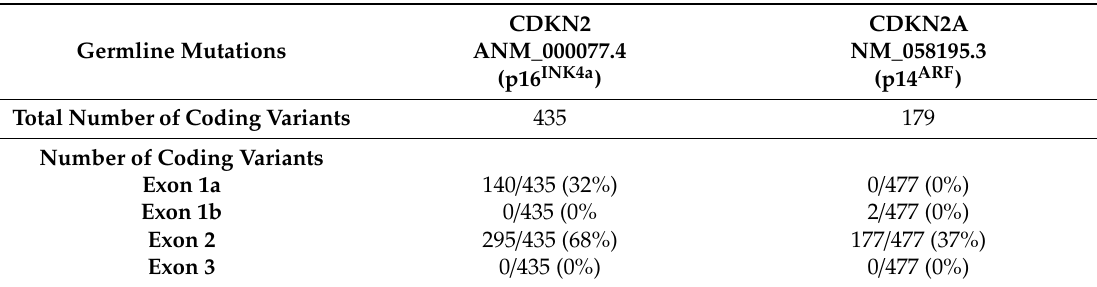
Table 2. Frequency and type of germline CDKN2A alterations identified in 676 individuals with various cancers, including melanoma and pancreatic